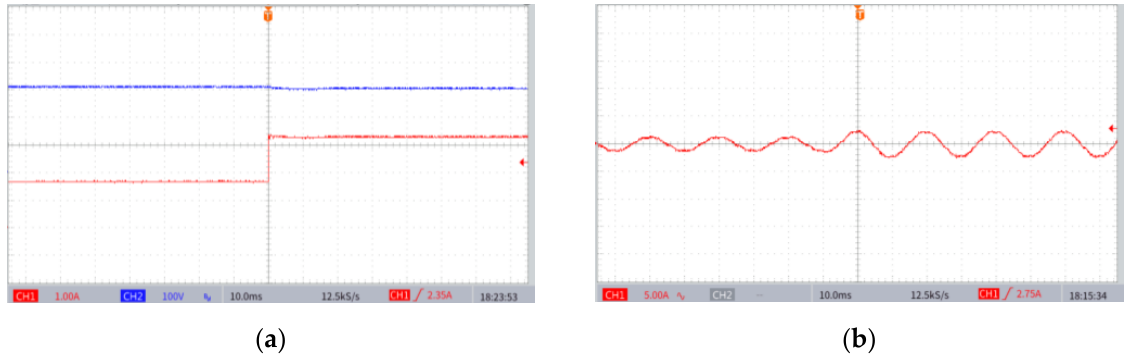
Figure 18. The input and output of the rectifier when the load changes. ( a ) Simulation result. ( b ) Experimental result.